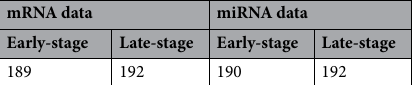
Table 5. Information of mRNA and miRNA